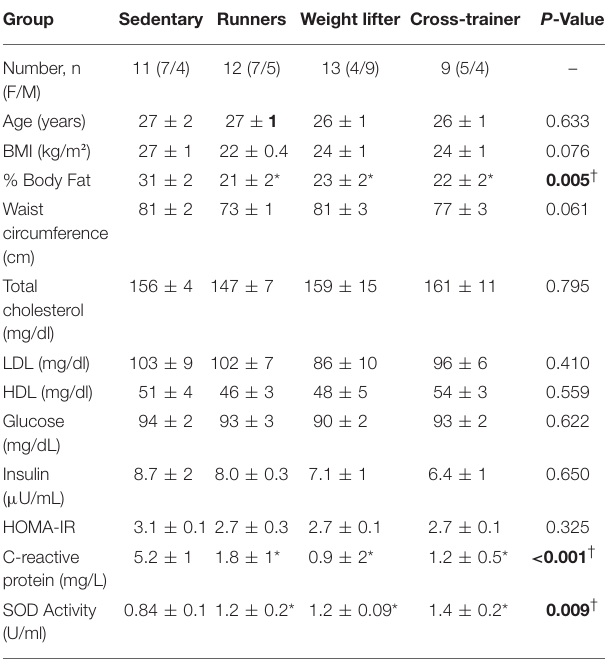
BMI, body mass index; HDL, high density lipoprotein; LDL, low density lipoprotein; SOD, superoxide dismutase. † Indicates significance for One-way ANOVA (P < 0.05). * Indicates significant difference observed vs. sedentary participants (P <